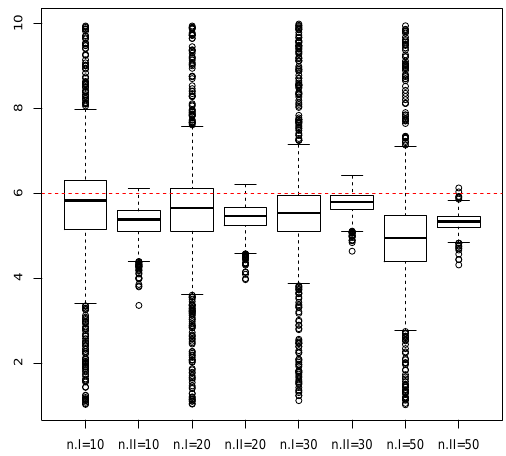
Figure 3. The boxplots of 1000 Bayes estimates of b 0 , where “n.I” and “n.II” indicate that procedures BE-I and BE-II are implemented with sample size n , respectively.